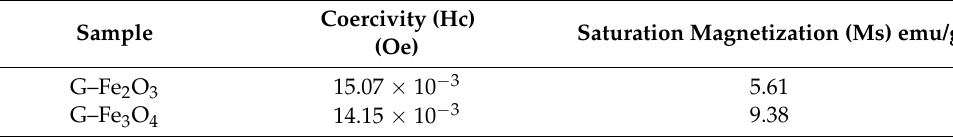
Table 5. Magnetic properties analysis of G–Fe 2 O 3 and G–Fe 3 O 4 .